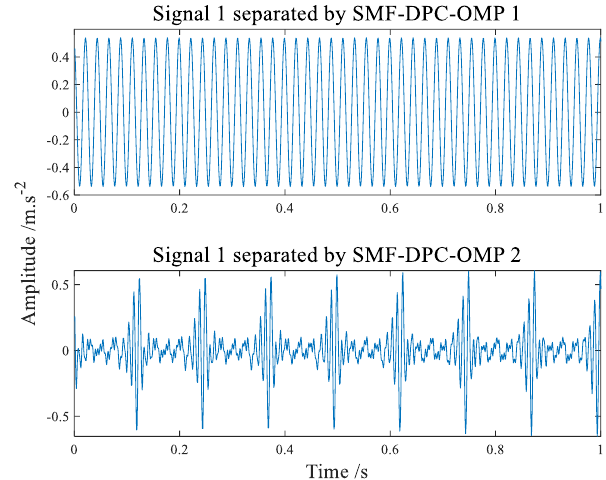
Figure 8. The time − domain waveform of separated signal.